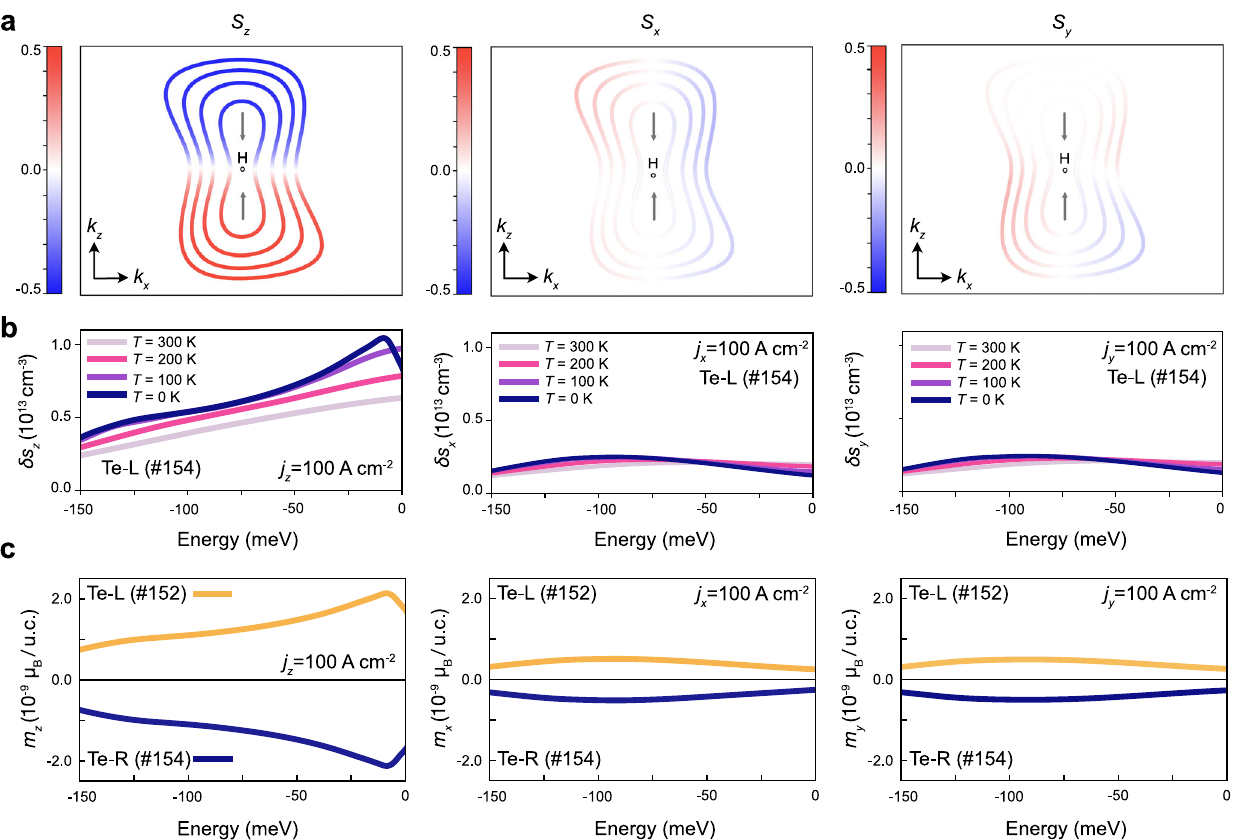
Fig. 2 Spin-resolved electronic structure and spin accumulation in bulk Te. a The calculated isoenergy contours projected onto the k x − k z plane passing through the H point in the left-handed Te. The energy eigenvalues are selected at 10, 30, 50, and 70 meV below the Fermi level, counting from the center. The color maps superimposed on the contours represent the expectation values of S x , S y , and S z shown at the left, middle, and right panels, respectively. The spin texture is radial with respect to the H point and nearly persistent along k z , as indicated by the arrows. b Spin accumulation per volume induced by the charge current j = 100 A cm 2 applied along z , x , and y direction in the left-handed Te, represented by left, middle, and right panel, respectively. Different lines correspond to temperatures in the range from 0 to 300 K. c The corresponding magnetization per unit cell was calculated for the left-handed (blue lines) and right-handed Te (orange lines) at 0